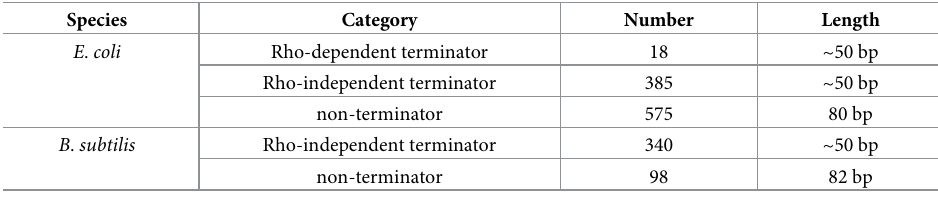
Table 1. Benchmark dataset.